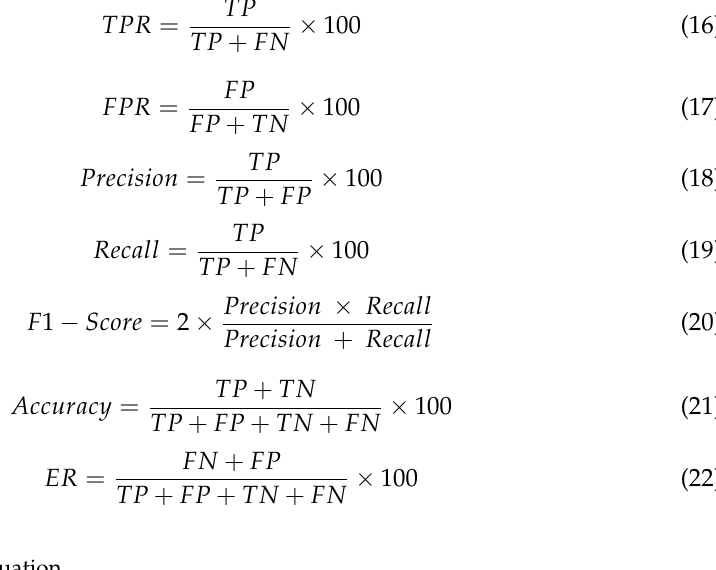
Table 3. Performance